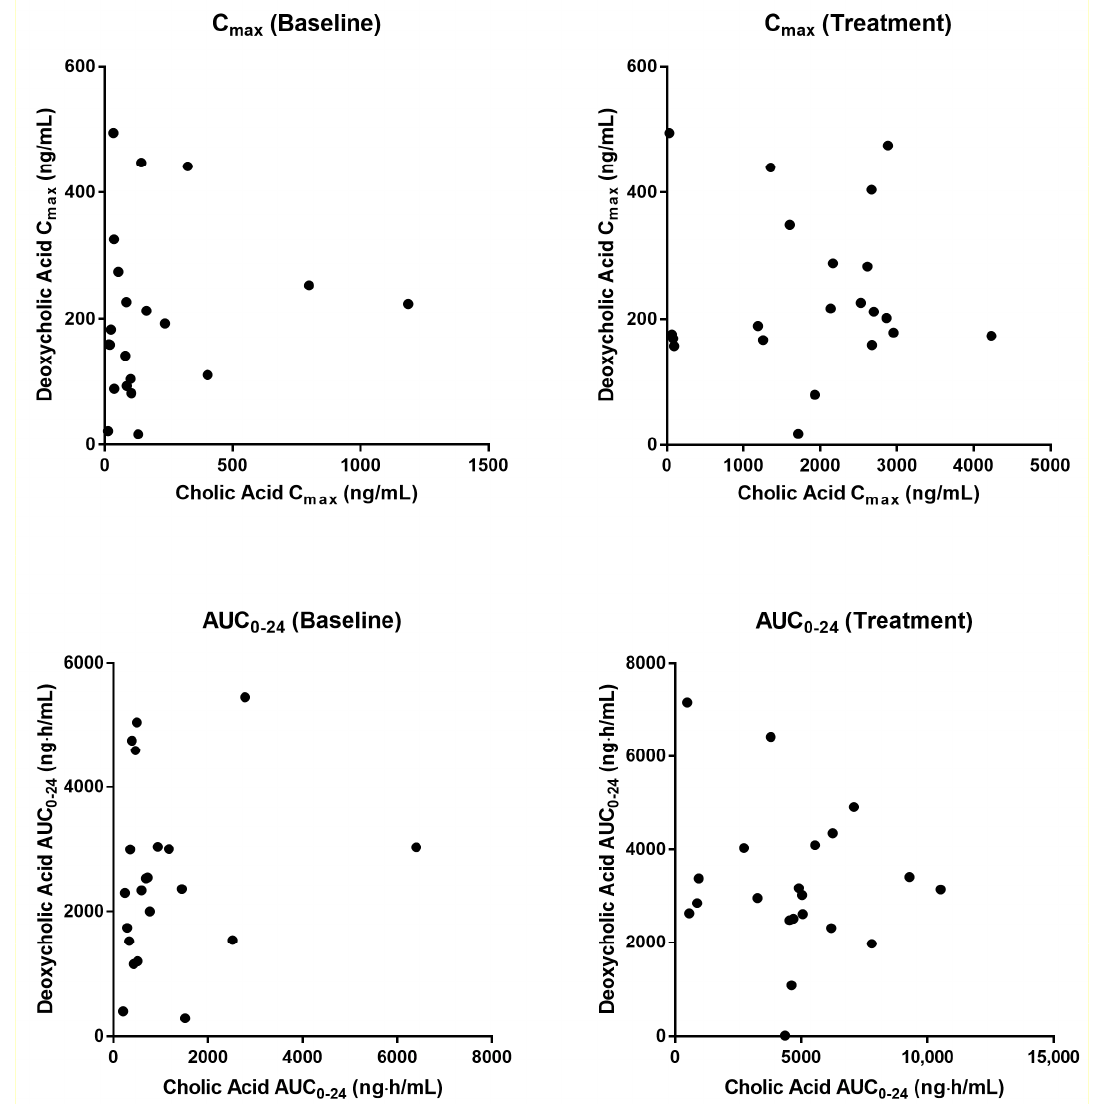
Figure 3. Relationship of pharmacokinetic parameters between cholic acid and deoxycholic acid.